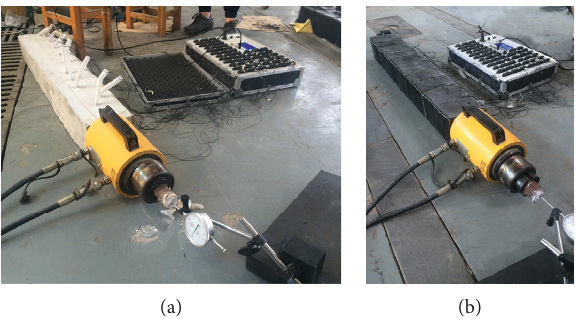
Figure 4: Pullout test under two types of constraint conditions: (a) unconstrained condition; (b) strong constraint condition.